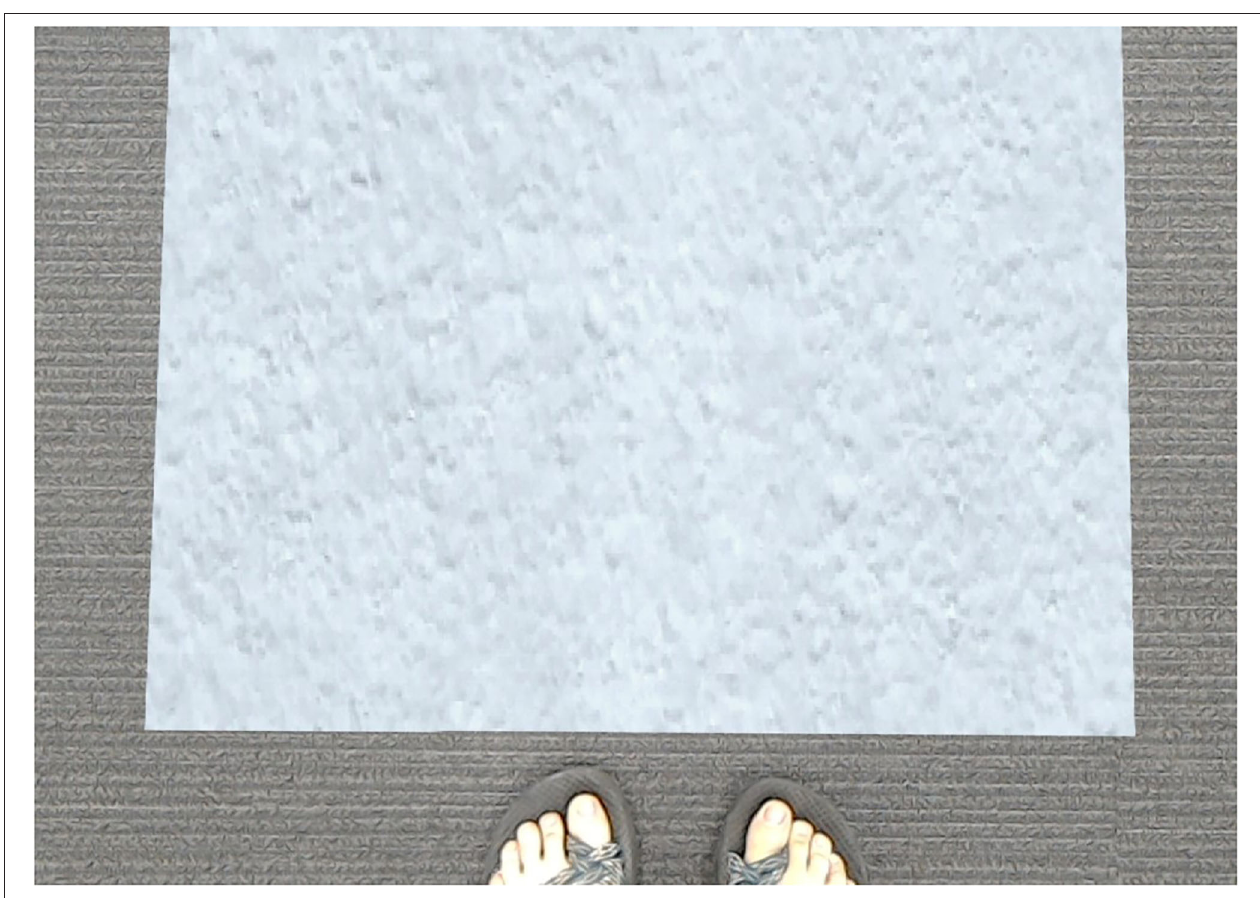
FIGURE 2 | Participant view of an augmented gap for the AR condition in Experiments 1 and